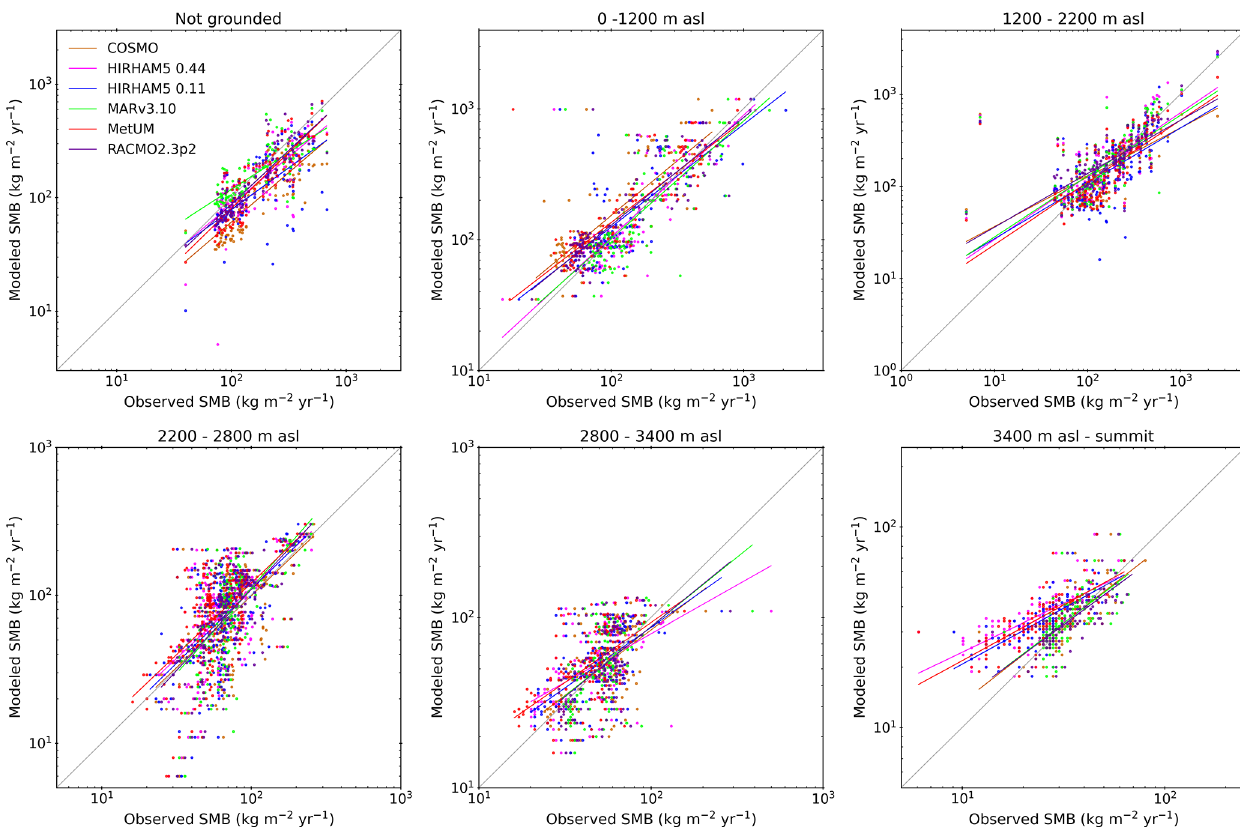
Figure 3. Comparison between modelled SMB and observed SMB in a gridded dataset. Trend lines and points are plotted for each model in a different colour. Note different x and y axes for different elevation bins. The figures are plotted on logarithmic axes because the datasets do not have Gaussian distributions, and this better represents the relative error in both high- and low-SMB regions than linear